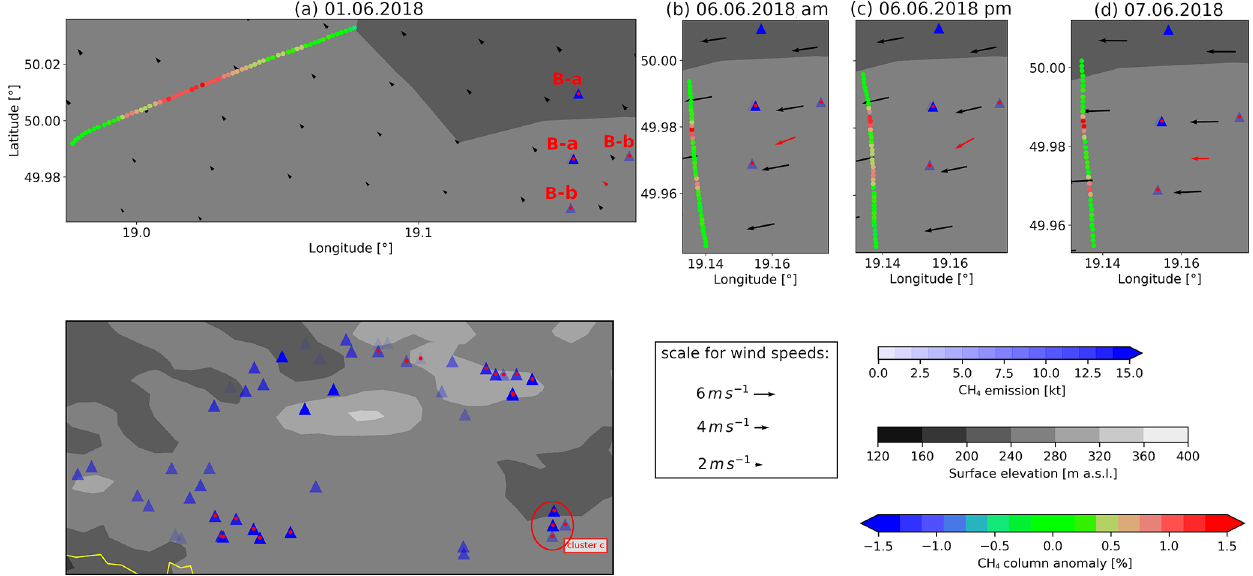
Figure C4. Same as Fig. 5 but for shaft cluster c in the south-eastern part of the study area (B-a: Brzeszcze-a, B-b: Brzeszcze-b). The corresponding cross-sectional fluxes are summarized in Table C1, and detailed cross-sections are found in Fig. C5.